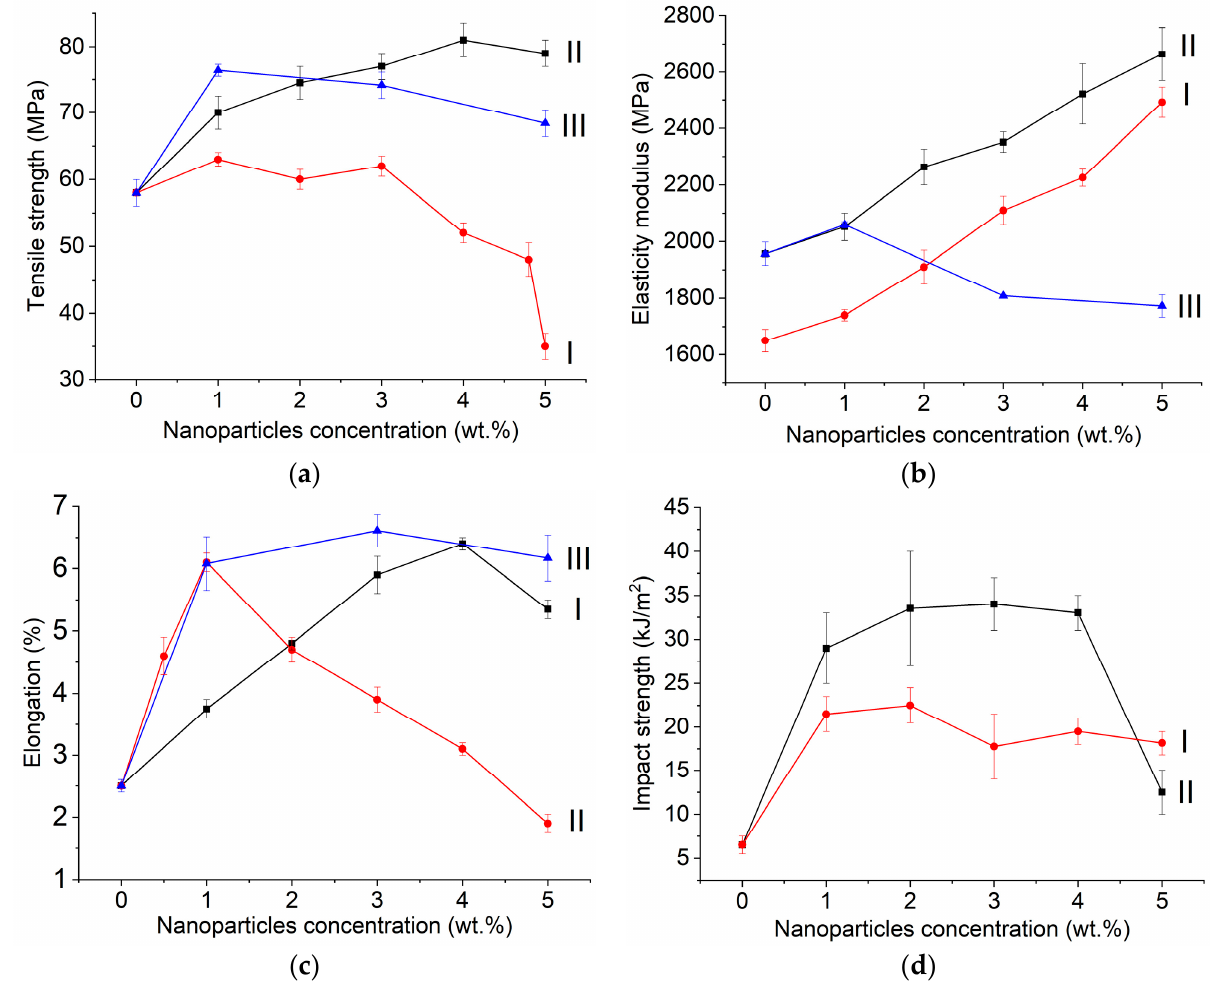
Figure 8. Mechanical properties: tensile strength ( a ), elasticity modulus ( b ), and elongation under maximum tension ( c ); and Charpy impact strength ( d ). Symbols: I—TiO 2 /EP of System I ( d av = 46 nm), II—TiO 2 /EP of System II ( d av = 100 nm), and III—TiO 2 /EP of System III ( d av = 46 nm + L61).